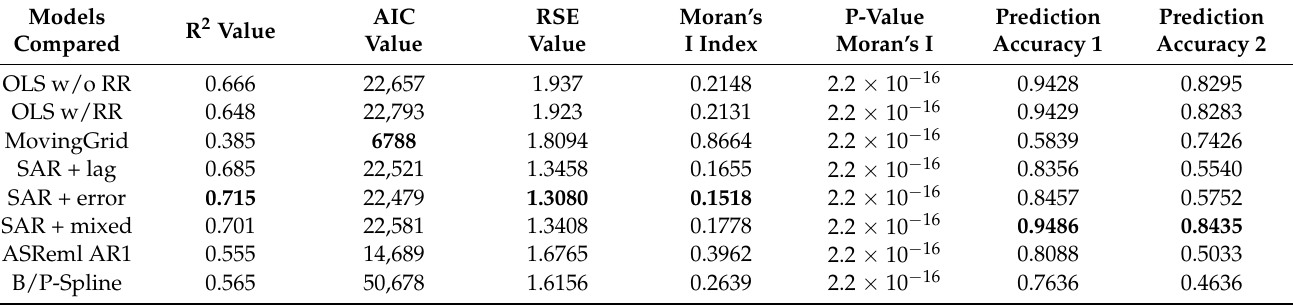
Table 7. Summary of the comparison among different models via R 2 , residual variance, prediction accuracy, and Moran’s I index from data set 2. OLS w/o RR stands for ordinary least square without range and row; OLS w/RR for ordinary least square with range and row. The most desirable values in each column are